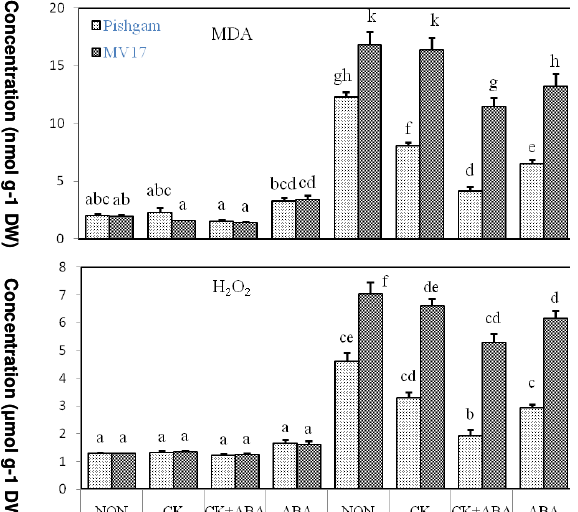
Fig. 4. Effect of hormonal treatments of CK, ABA and CK/ABA on H O and MDA content under irrigation and 2 2 drought condition in flag leaves during grain filling in two wheat cultivars (drought tolerant cv. ‘ Pishgam ’ (white columns) and drought sensitive cv. ‘ MV-17 ’ (black